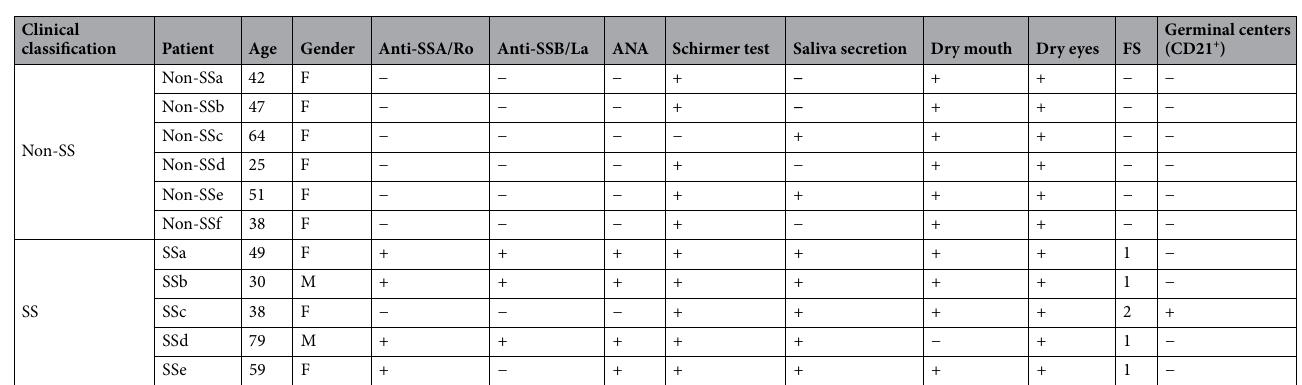
Table 3. Additional patient samples used for RNAScope (Oslo cohort). ANA antinuclear antibodies; Saliva secretion (unstimulated flow); Schirmer test positive when reduced tear secretion (objective test); Dry mouth and dry eyes, subjective symptoms from the patient, FS Focus